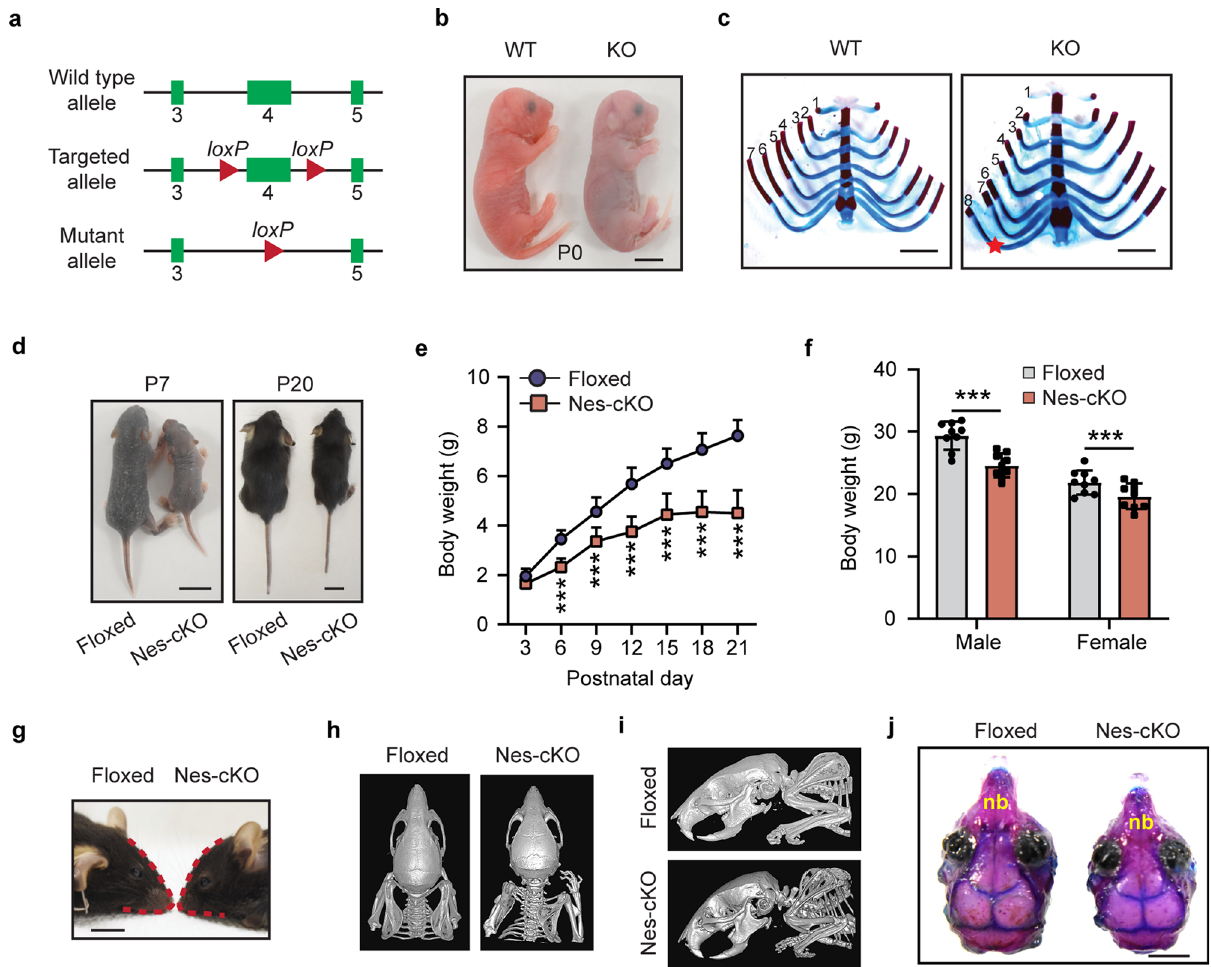
Fig. 1 Characterization of Ash1L knockout mice. a Diagram showing the strategy for the generation of Ash1L conditional knockout mice. b Representative photos of wild-type and global Ash1L -KO newborns at P0. The Ash1L -KO newborns died at P0, bar = 5 mm. c Photos showing the ventral view of rib cages of wild-type and Ash1L -KO mice, bar = 2 mm. d Representative photos showing the body size of wild-type and Ash1L -Nes-cKO mice at P7 and P20, bar = 1 cm. e Postnatal growth curve of wild-type and Ash1L -Nes-KO mice before weaning. Mixed gender body weight was plotted. For each group, n = 15 mice. P- values calculated using a two-way ANOVA test. Error bars in graphs represent mean ± SEM. Note: ** p < 0.01; *** p < 0.001. f Body weight of adult wild-type and Ash1L -Nes-cKO mice. All the mice were measured at 3-month old. For each group, n = 9 mice. P- values calculated using a two-way ANOVA test. Error bars in graphs represent mean ± SEM. Note: *** p < 0.001. g Photo showing the craniofacial deformity of Ash1L -Nes-cKO mice, bar = 5 mm. h – i A dorsal (h) and lateral (i) view of mouse skull shown by micro-CT scanning. j A dorsal view of skull shown by bone staining. nb, nose bone, bar = 2